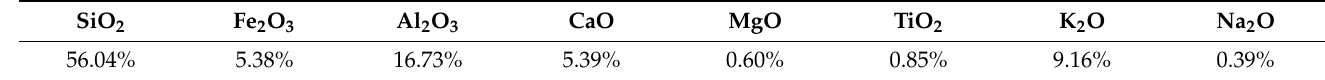
Table 1. Oxide composition of the used tuff [32].